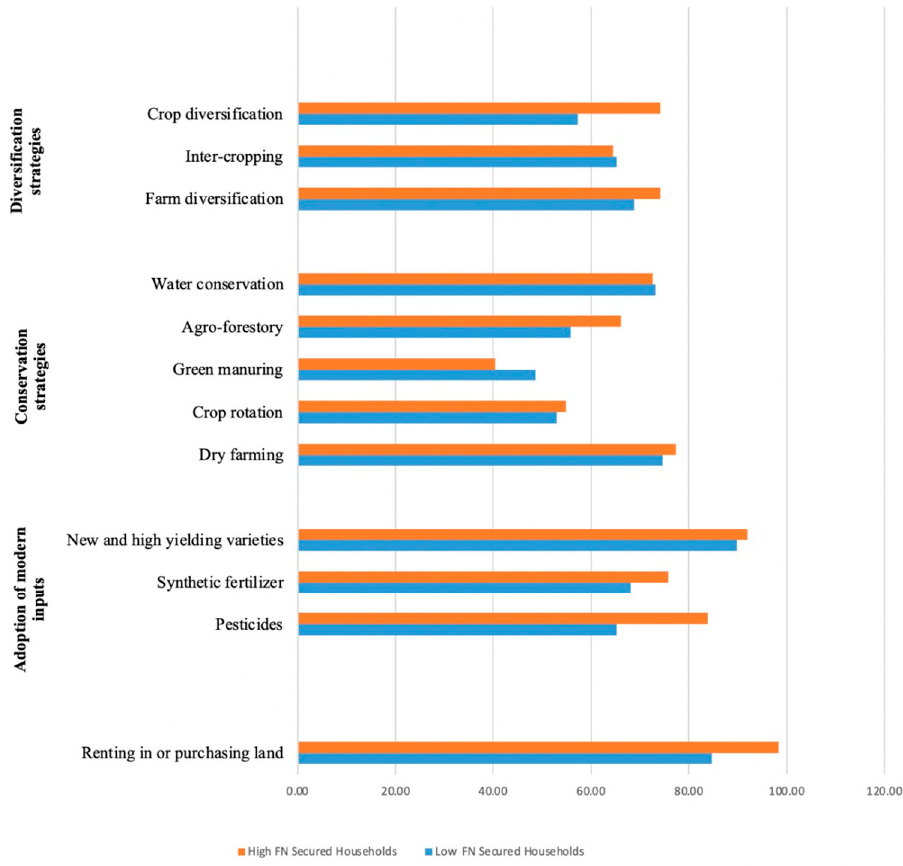
Figure 4. Prevalence of farm-level strategies among high and low FNS households.